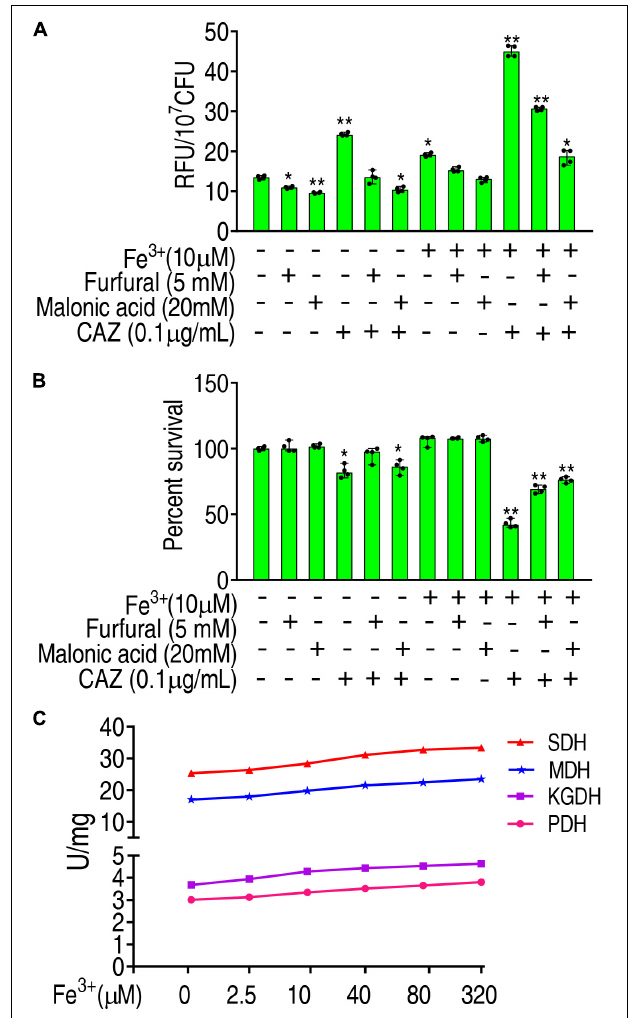
FIGURE 6 | Promotion of Fe 3 + to the P cycle. (A) ROS of LTB4-R CAZ in the presence of Fe 3 + and CAZ plus inhibitors of the P cycle. (B) Percent survival of LTB4-R CAZ in the presence of Fe 3 + and CAZ plus inhibitors of the P cycle. (C) The activity of PDH, KGDH, SDH, and MDH in the presence of Fe 3 + . Results are displayed as mean ± SEM, as determined by two-tailed Student’s t -test. Four biological repeats are carried out. * p < 0.05 and ** p < 0.01.